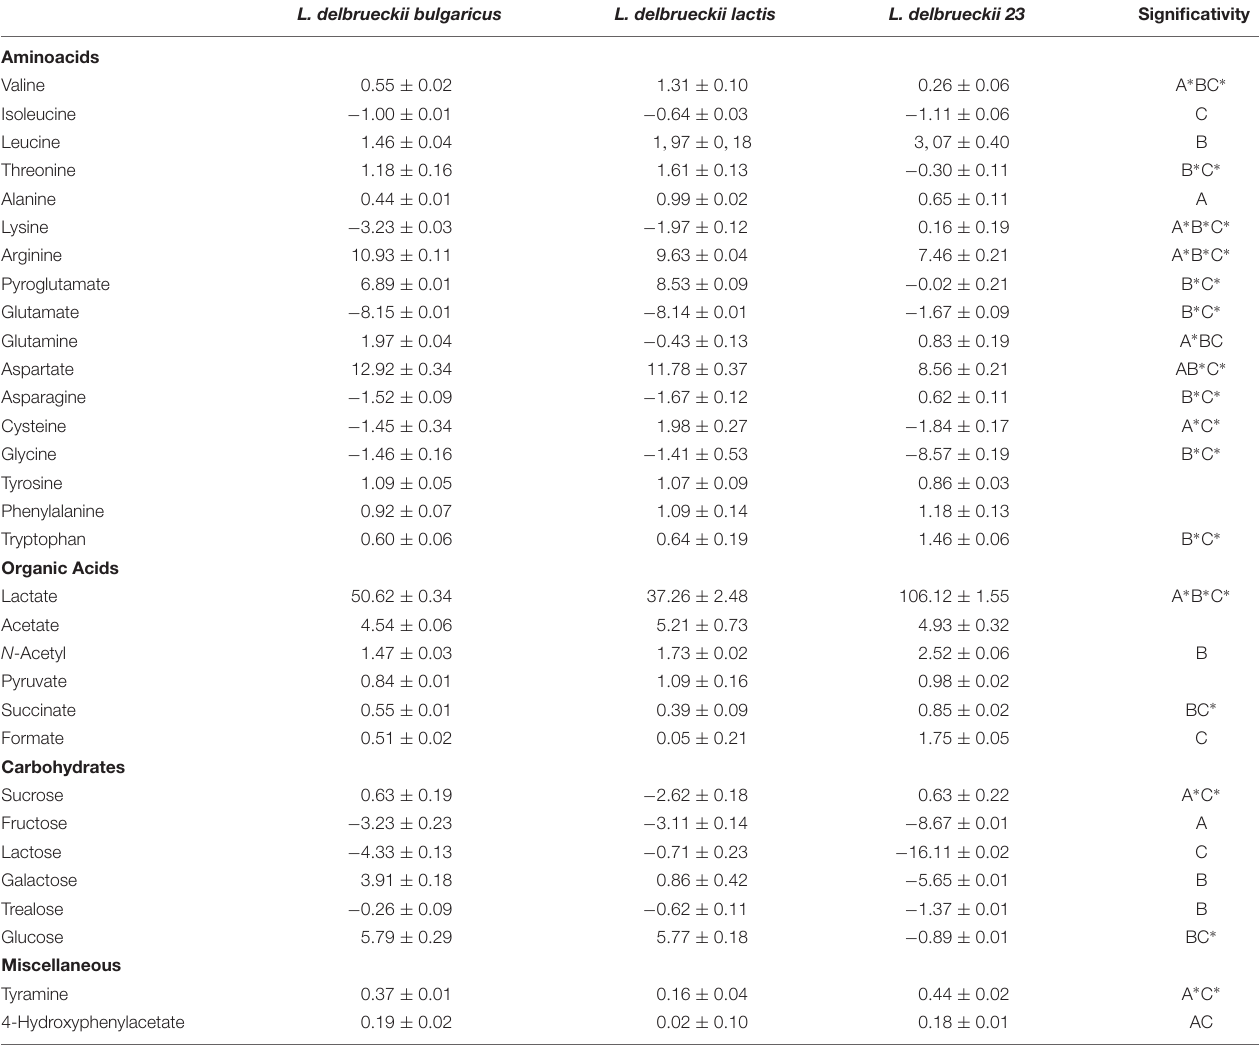
TABLE 2 | Medium balances expressed as mM and calculated as the average of three samples + / − standard